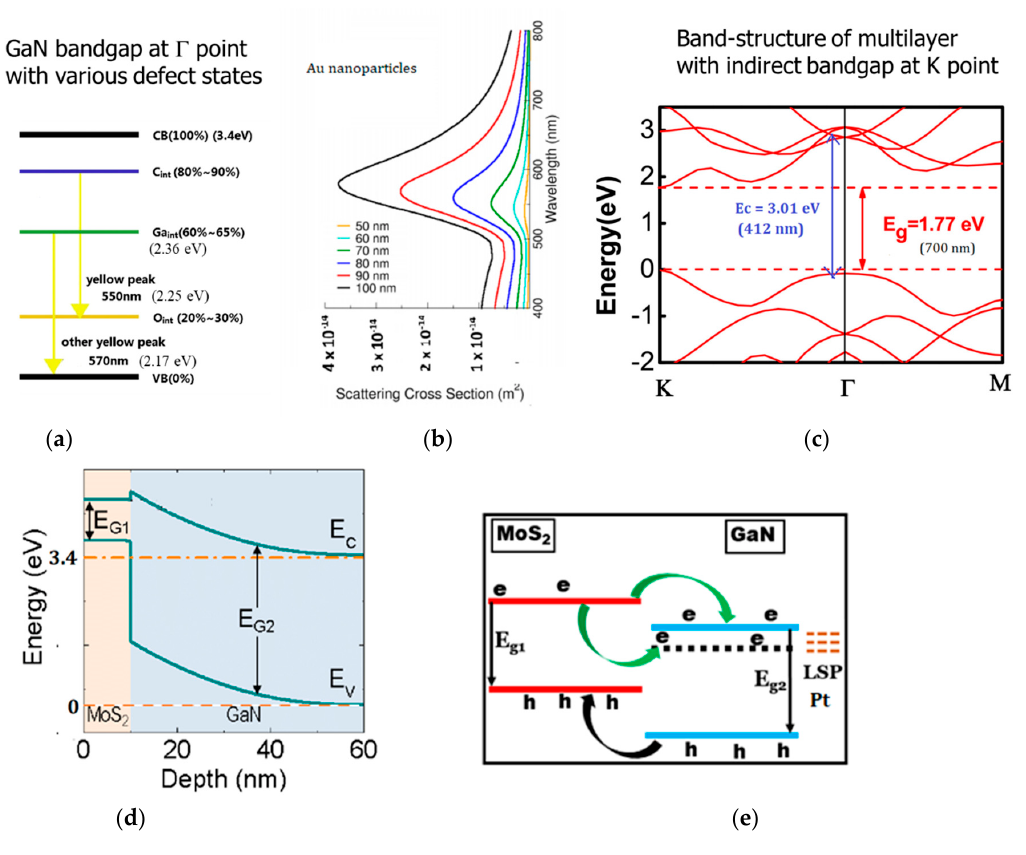
Figure 1. Schematic showing the band line up of hybrid MoS 2 -GaN hybrid semiconductor system. ( a ) GaN bandgap at the gamma point with Gallium interstitial, oxygen, and interstitial carbon